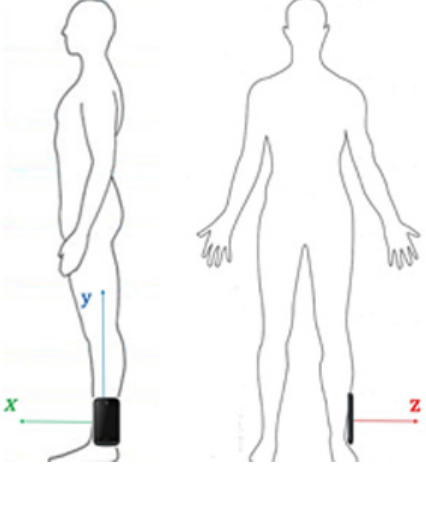
Figure 6. The mount position of the smartphone in walking and turning